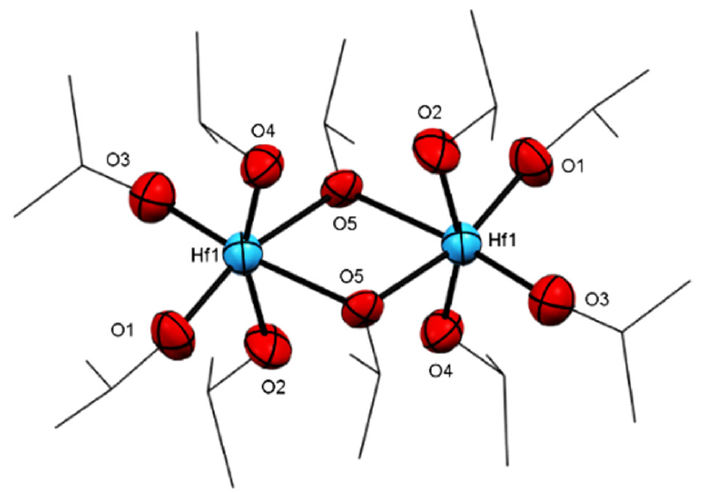
Figure 8. ORTEP drawing of 8 [Hf 2 (O i Pr) 8 · ( i PrOH) 2 ]. Isopropyl atoms are shown in wireframe mode to clarify the structure. Hydrogen atoms are omitted for clarity.